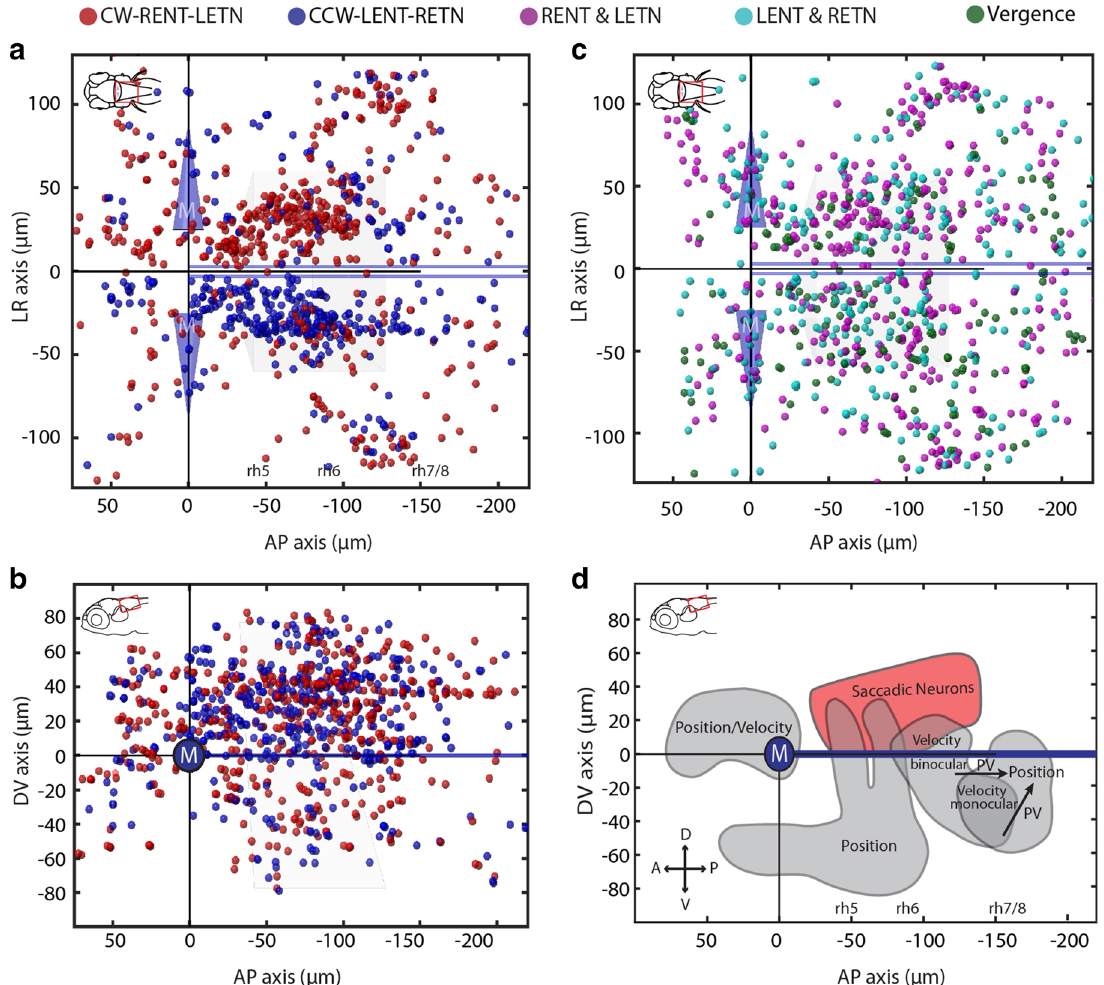
Figure 5. Anatomical distribution of putative burst neurons in the zebrafish hindbrain. Each colored ball represents an identified saccade-associated neuron. ( a , b ) Dorsal and sagittal cell maps for CW-LETN-RENT and CCW-LENT-RETN neurons. ( c ) Dorsal cell map for pooled Helmholtz-like neurons representing clockwise (RENT type and LETN type) and counter-clockwise (RETN type and LENT type) directions, as well as vergence (convergent, divergent) neurons. ( d ) Sagittal schematic illustrating the position of the major cluster of SA neurons (red) relative to the position of other neuron types (grey) identified in a previous study (adapted from Brysch, Leyden and Arrenberg 16 , licensed under CC BY 4.0 (http:// creat iveco mmons. org/ licen ses/ by/4. 0/)). In ( a – c ), the trapezoid box represents the abducens nucleus, and the blue cones represent the Mauthner (M) cell bodies. The medial longitudinal fasciculus is represented by the thick blue lines parallel to the larval midline. D dorsal; V ventral; A anterior; P posterior; DV dorsal–ventral; AP anterior–posterior. Data from n = 30 larvae is merged in the anatomical plots ( a – c ), corresponding to approximately 3.5–7 completely imaged hindbrains in the range of − 80 to 40 µm (see